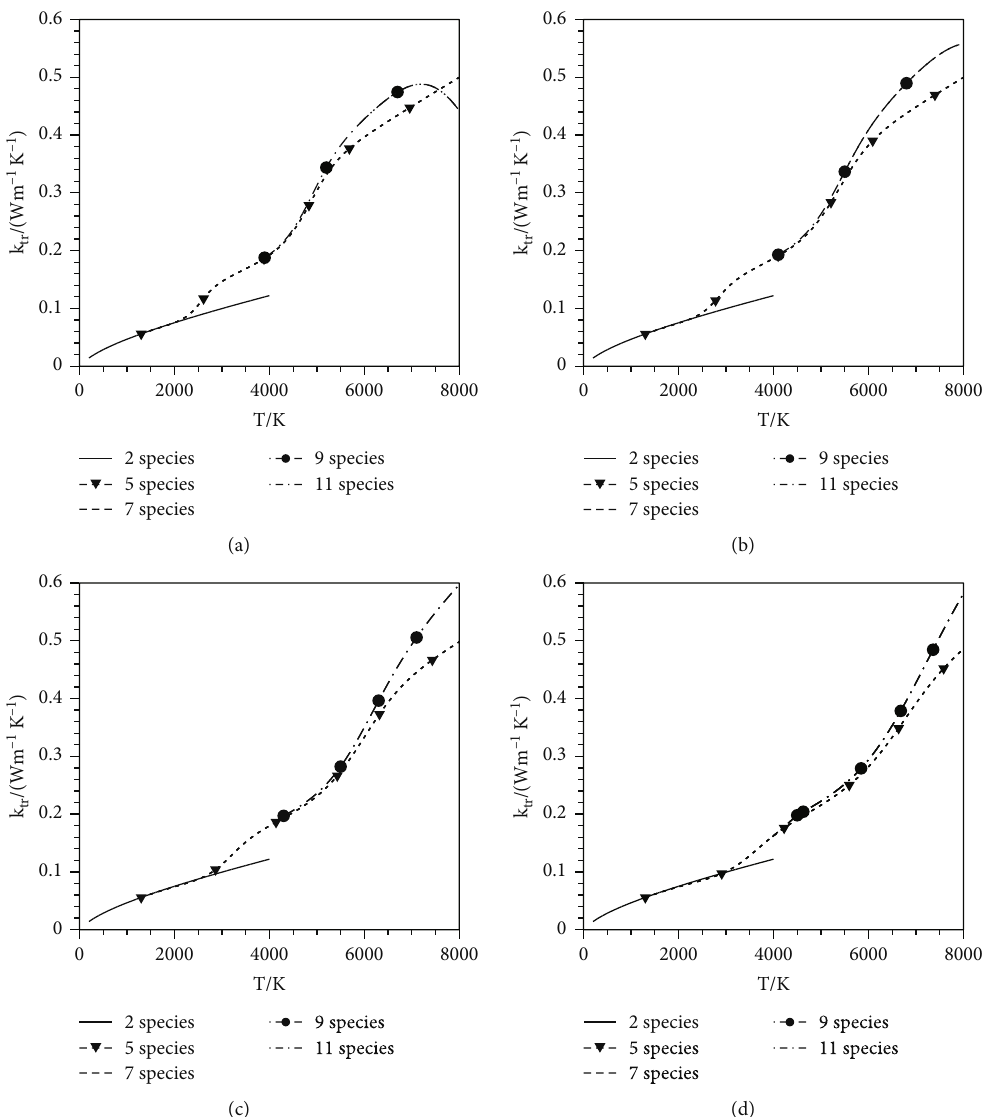
Figure 3: Translational thermal conductivity coe ffi cients at di ff erent pressure conditions. (a) 0.001 atm, (b) 0.01atm, (c) 0.1atm, and (d)